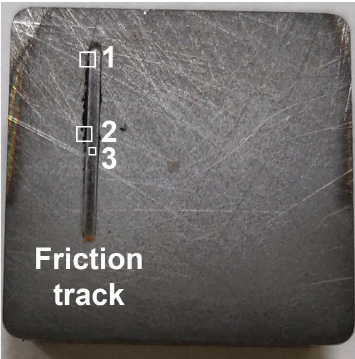
Figure 1. Coated sample after friction tests (numbers indicate the areas under study). Table 1. Chemical composition (wt.%) of 52,100 steel.